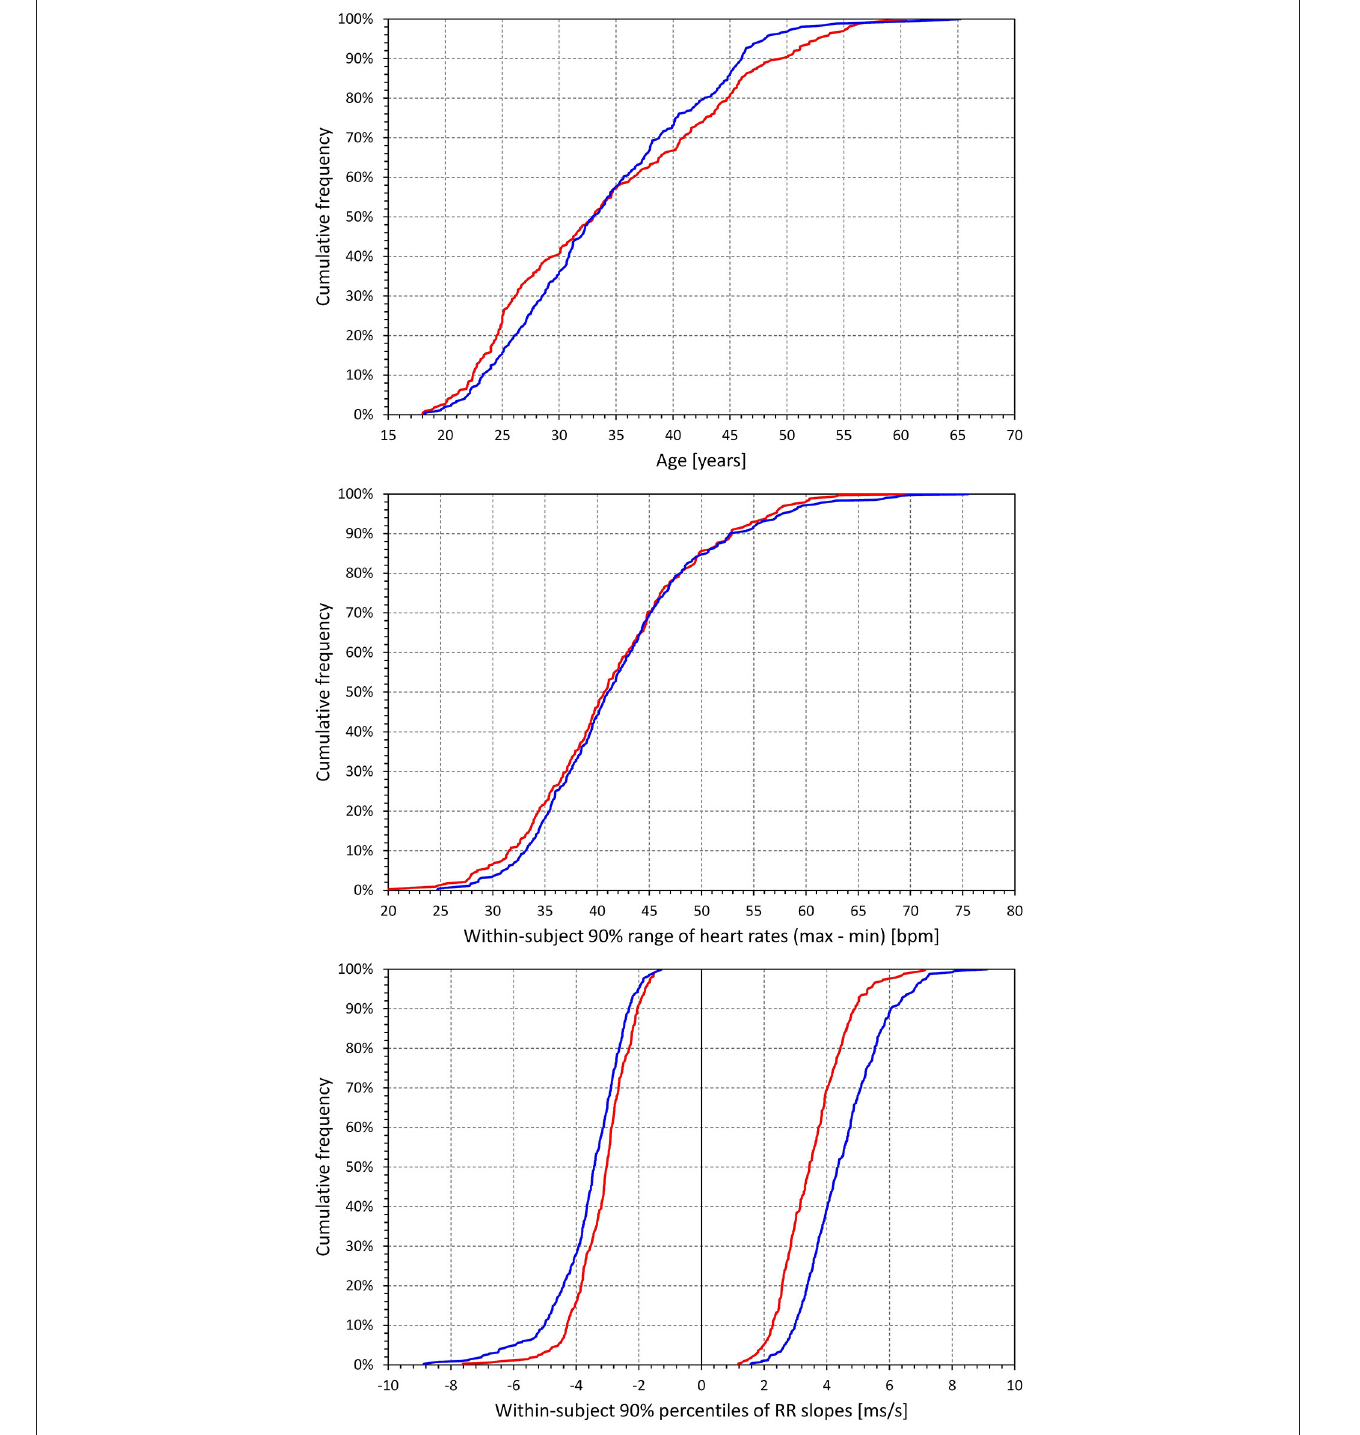
FIGURE 2 | Characteristic of the study population and electrocardiographic measurements. Top panel shows cumulative distributions of the ages of investigated subjects. The middle panel shows cumulative distributions of the 90% ranges of intra-subject heart rates in study subjects (that is, in each study subject, difference between the 5th and 95th percentiles of heart rates at which the QT interval was measured was calculated, and the panel shows the cumulative distribution of these differences). The bottom panel shows the cumulative distributions of the intra-subject 5th and 95th percentiles of the RR interval slopes preceding QT interval measurements (that is, for each subject, 60-s slopes of RR interval durations vs. their index numbers were obtained for each RR history of QT interval measurements, and the graphs show the distribution of the intra-subject 5th and 95th percentiles of these slopes. In each subject, the 5th percentile corresponded to heart rate deceleration, distributions below 0, and the 95th percentile corresponded to heart rate acceleration, distributions above 0). In each graph, the red and blue lines correspond to the female and male subjects, respectively.